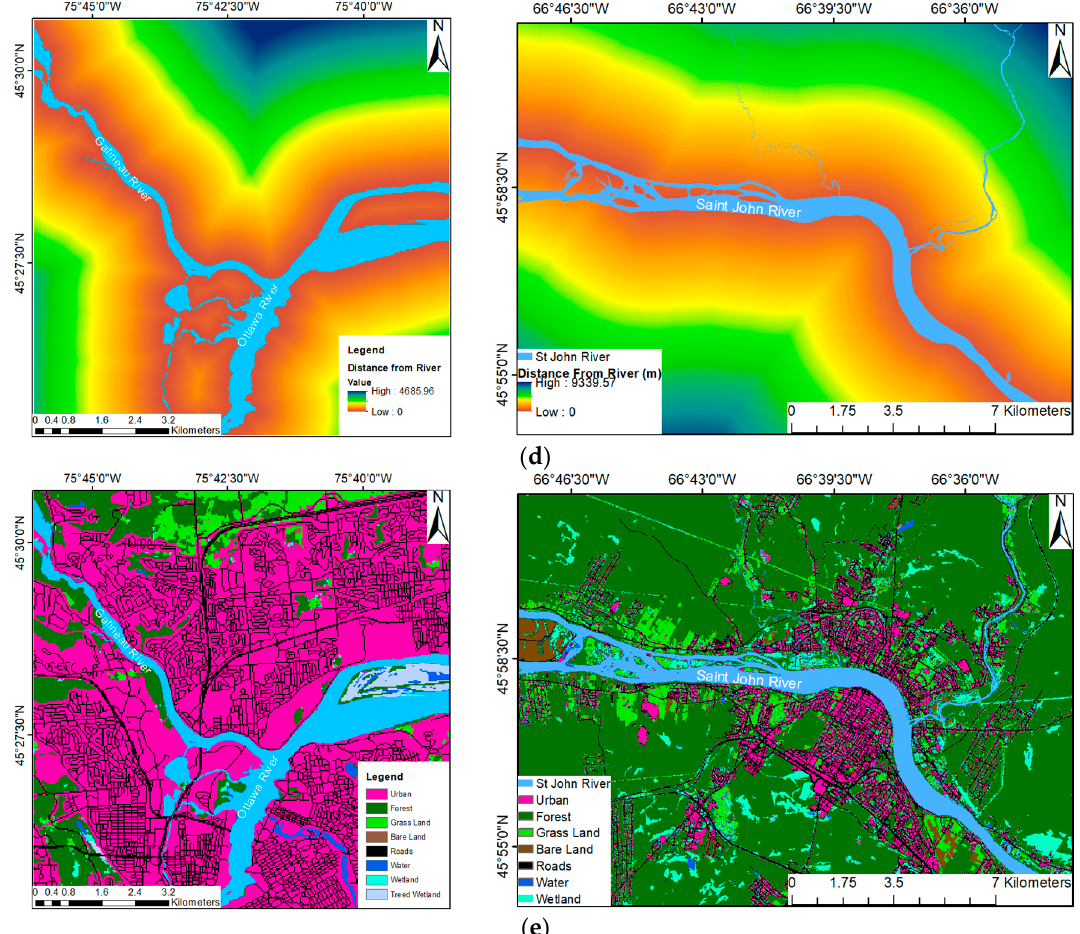
Figure 4. Conditioning factors: ( a ) Altitude, ( b ) Slope, ( c ) Aspect, ( d ) Distance from River, ( e ) Land use/cover for ( left ) Gatineau, ( right ) Fredericton.